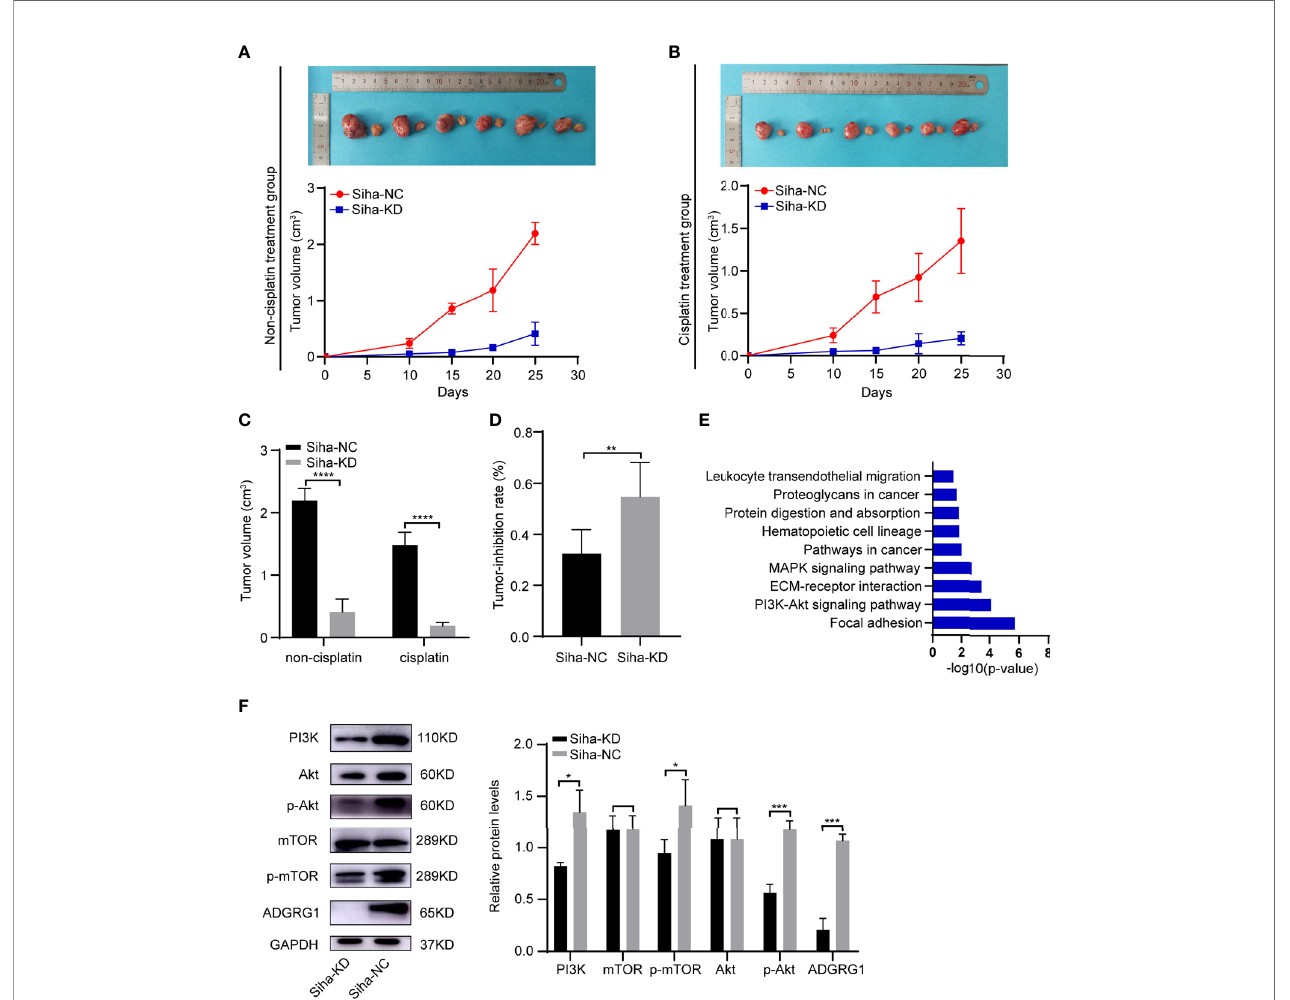
FIGURE 7 | In vivo effects of ADGRG1 expression on tumorigenesis and sensitivity to cisplatin treatment, as well as relevant mechanism. (A, B) Photographs of xenograft tumors of Siha-NC and Siha-KD in non-cisplatin treatment group and cisplatin treatment group. (C, D) Growth curves of xenograft tumors in non-cisplatin treatment group and cisplatin treatment group (**P < 0.01, ****P < 0.0001). (E) KEGG pathway enrichment analysis of the DEGs from GSE104653 datasets. (F) Detection of PI3K/Akt signaling pathway-related genes at the protein level in Siha-KD and Siha-NC by western blotting (*p < 0.05, ***p <